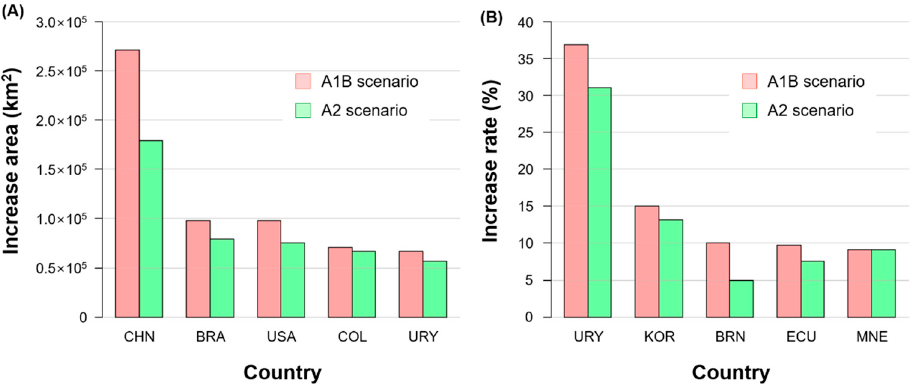
Figure 7. Top five countries for ( A ) increased area and ( B ) increased rate of climatic suitability (>0.2) for S. geminata in the future (2050) compared to current conditions according to global warming scenarios A1B and A2. BRA: Brazil, BRN: Bru-